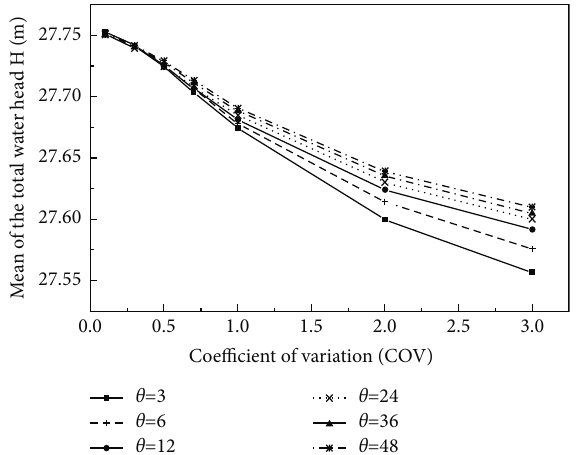
Figure 6: Mean of the total head versus COV of the hydraulic conductivity.